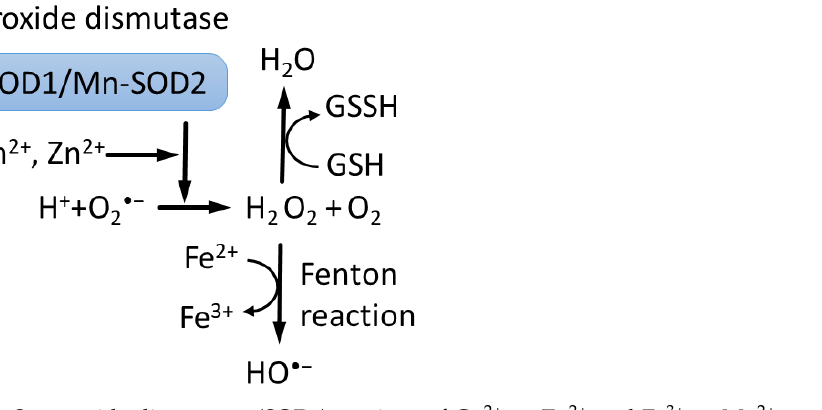
Figure 1. Superoxide dismutases (SODs) use ions of Cu 2+ or Zn 2+ and Fe 3+ or Mn 2+ to catalyze reduc- tion of superoxide O 2• − to hydrogen peroxide H 2 O 2 [6,52] . In turn, Fenton reaction converts hydrogen